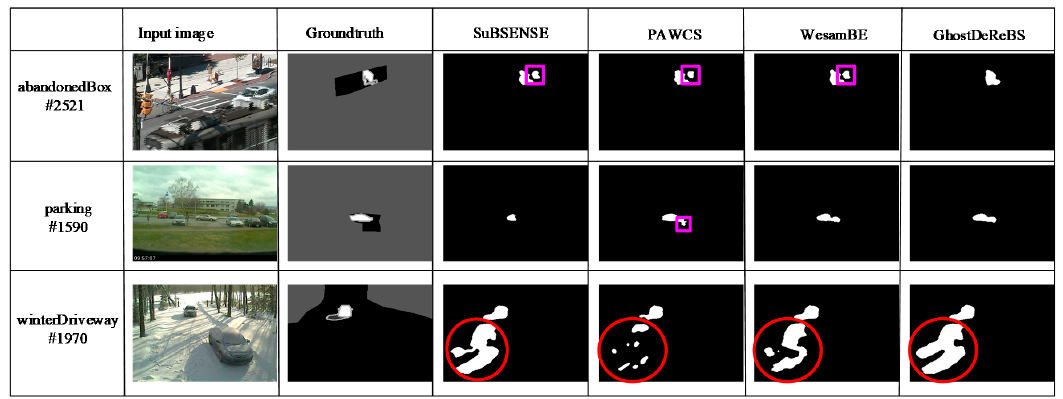
Figure 8. Analysis of advantages and disadvantages of our proposed method in ghost